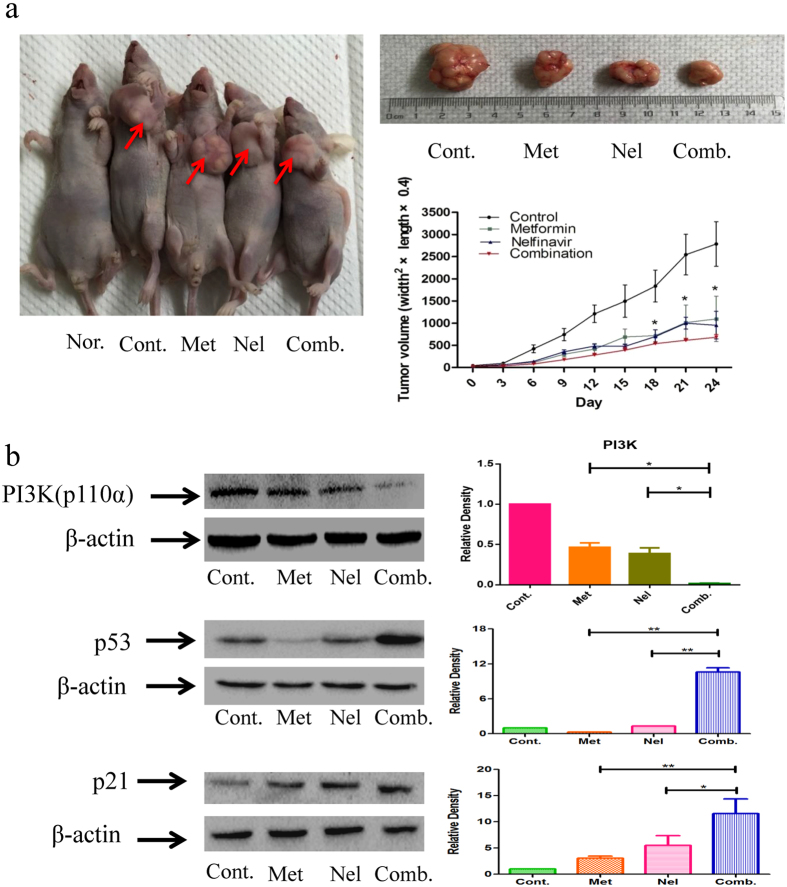
Inhibition of tumor growth in mouse model by metformin and nelfinavir, alone or in combination.(a) Inhibition of cervical tumor growth. SiHa cells (1 × 106) suspended in PBS were injected subcutaneously into the left flanks of female nude mice (BALB/c). The mice with tumors (0.3–0.4 cm wide and 0.3–0.4 cm long) were randomly assigned to each treatment and were injected i.p. with vehicle (5 μL/g body weight), metformin (100 mg/kg), nelfinavir (0. 4 mg/kg), or metformin (100 mg/kg) plus nelfinavir (0. 4 mg/kg) three times per week for 24 days (n = 5 per group). Tumor size (length and width) was measured before each i.p. injection, and tumor volume was calculated using the following formula: width2 × length × 0.4. The right panel shows the tumor volume in each group by day, and the middle and left panels show representative images of the tumors. Values are shown as means ± SE, n = 5. (b) Protein expression of PI3K, p53 and p21 in tumor tissues. The protein expression of PI3K, p53 and p21 in tumor tissues was analyzed by Western blotting with the indicated antibodies. Values are expressed as the fold change of the vehicle-treated control and are shown as the mean ± SE, n = 5. *p < 0.05, **p < 0.01, ##p < 0.01, compared to untreated control or individual drug (Nor, Normal; Mod, model; Met, metformin; Nel, nelfinavir; Comb, the combination of metformin and nelfinavir).